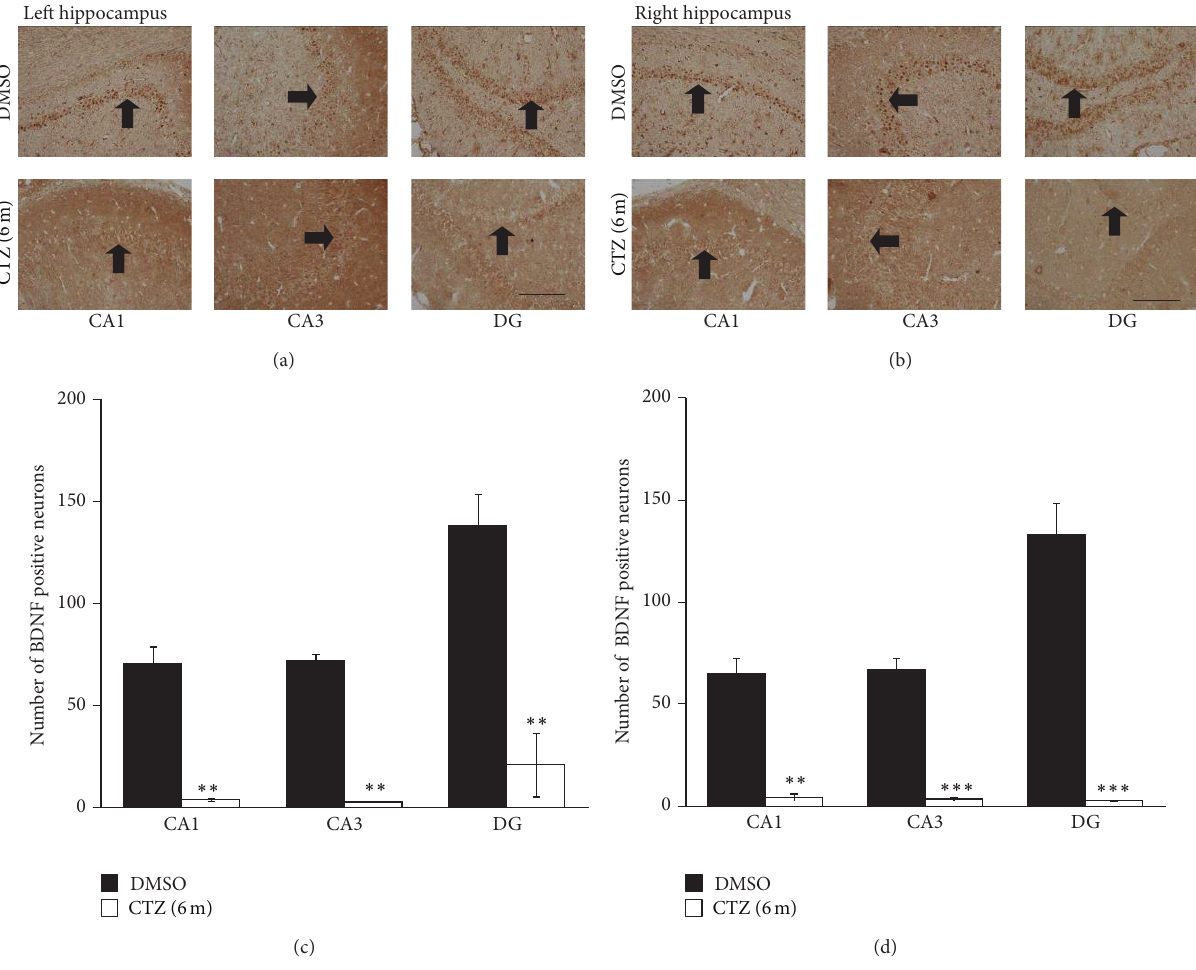
Figure6:DecreasedBDNFstaininginhippocampusofrecurrentseizurerats6monthsafterseizureinductionbyCTZ.(a-b)Picturesshowing BDNF positive cells (arrow indicated) in left (a) and right (b) hippocampus from rats 6 months after either DMSO (top) or CTZ (bottom) treatment. (c-d) Group data showing significant decreases of the BDNF staining cells in CA1, CA3, and DG area of the hippocampus from rats 6 months after either DMSO ( 𝑛 = 3 ) or CTZ ( 𝑛 = 3 ) treatment. ∗∗ 𝑃 < 0.01 , ∗∗∗ 𝑃 < 0.001 , compared to the DMSO control group. Scale bar in (a) and (b): 200 𝜇